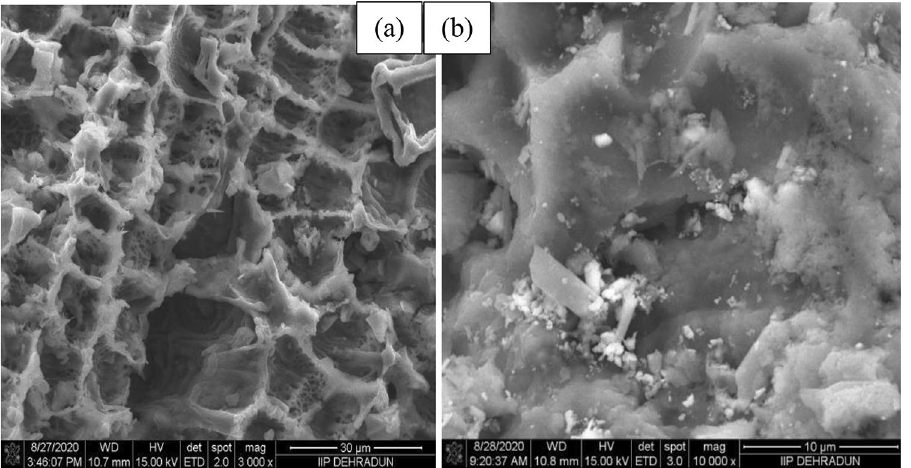
Figure 2. SEM images of ( a ) MBC and ( b ) 6TsOH-MBC